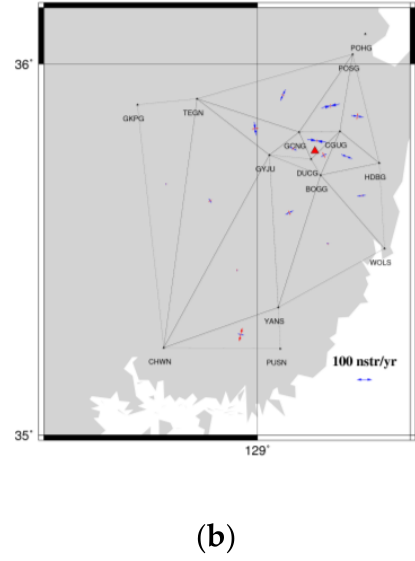
represent the annual axial strains, 𝛾 𝑥𝑦 represents the annual shear strain, [𝜖 𝛼 𝐴 , 𝜖 𝛼 𝐵 , 𝜖 𝛼 𝐶 ] is determined through GNSS stations as the distance change rate of each side, and the symbols [𝛼 𝐴 , 𝛼 𝐵 , 𝛼 𝐶 ] are the azimuth of the geodesic line. A Delaunay triangular network is composed of the GNSS stations around the Yang- san Fault Zone, which is used to calculate the baseline change rate based on the time series coordinates. Neglecting the curvature of the earth, the triangular network was assumed to be a two-dimensional plane. No triangle's circumcircle contains any other points except